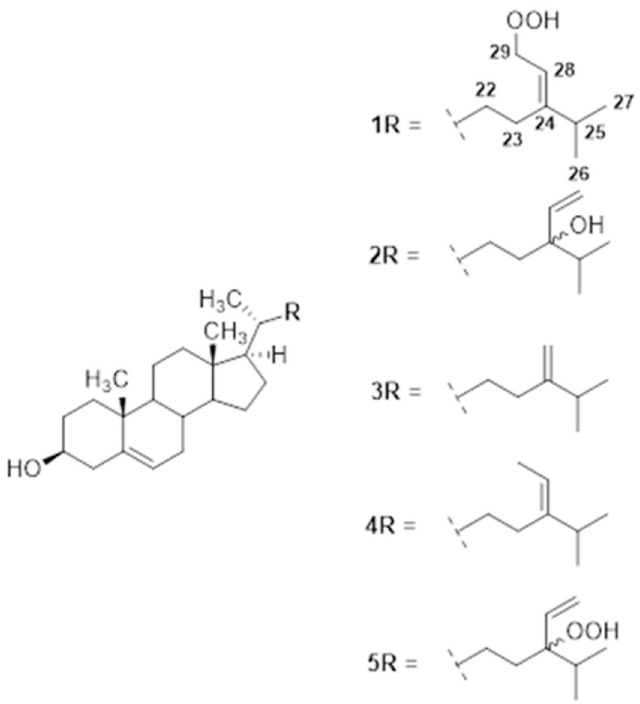
Fig 1. Chemical structures of the biologically active sterols (compounds 1–5) isolated from the hexane extract of L . japonica